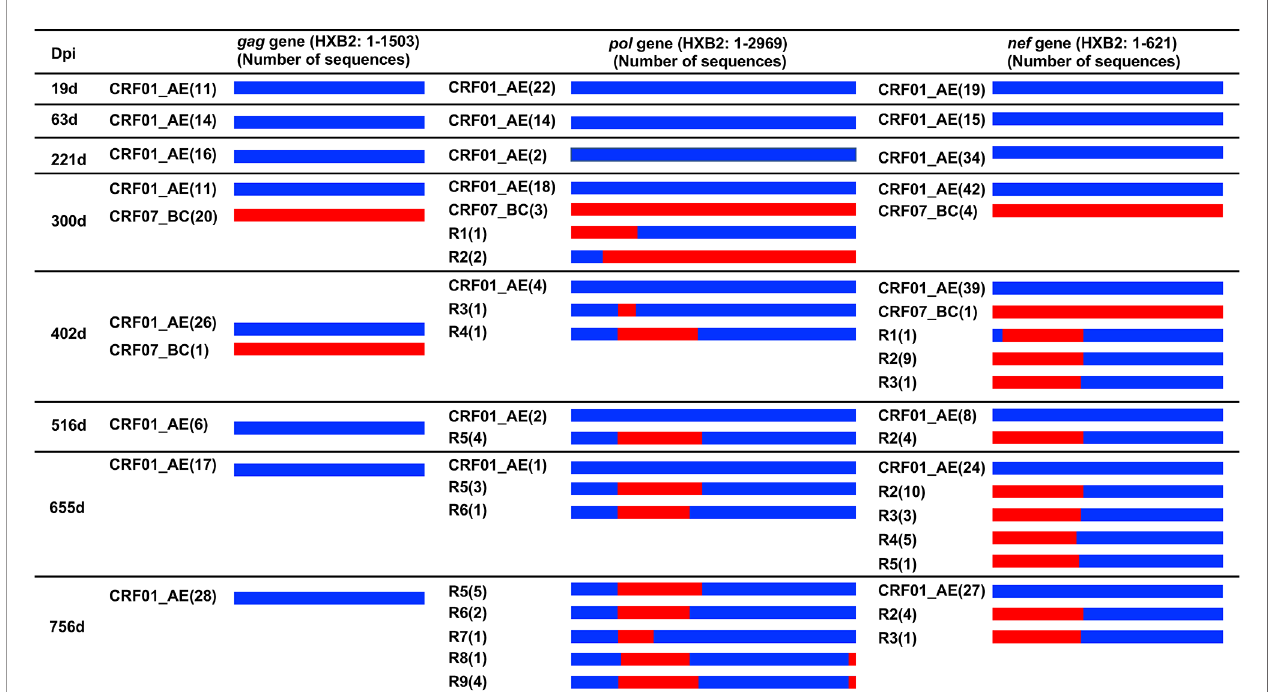
FIGURE 2 | Recombination structure analysis of the gag , pol and nef genes from patient LNA819 at longitudinal time points. The recombination structures were de fi ned by bootscanning using Simplot (v3.5.1) and then the breakpoints were identi fi ed and visually inspected in BioEdit. The fi rst column represents the time points of sample collection. The second to fourth columns describe the recombination forms of the gag , pol and nef genes. Initial CRF01_AE strains and superinfecting CRF07_BC strains are marked as slate-blue and red, respectively. The bracketed text indicates the number of sequences of the different strains. Dpi, days post-infection.